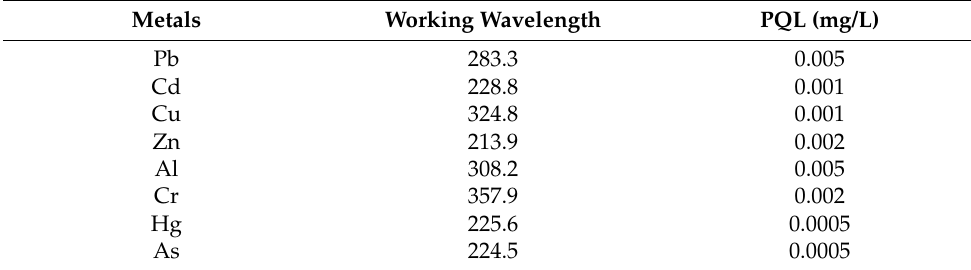
Table 1. Operating wavelengths and practical limits of quantification.